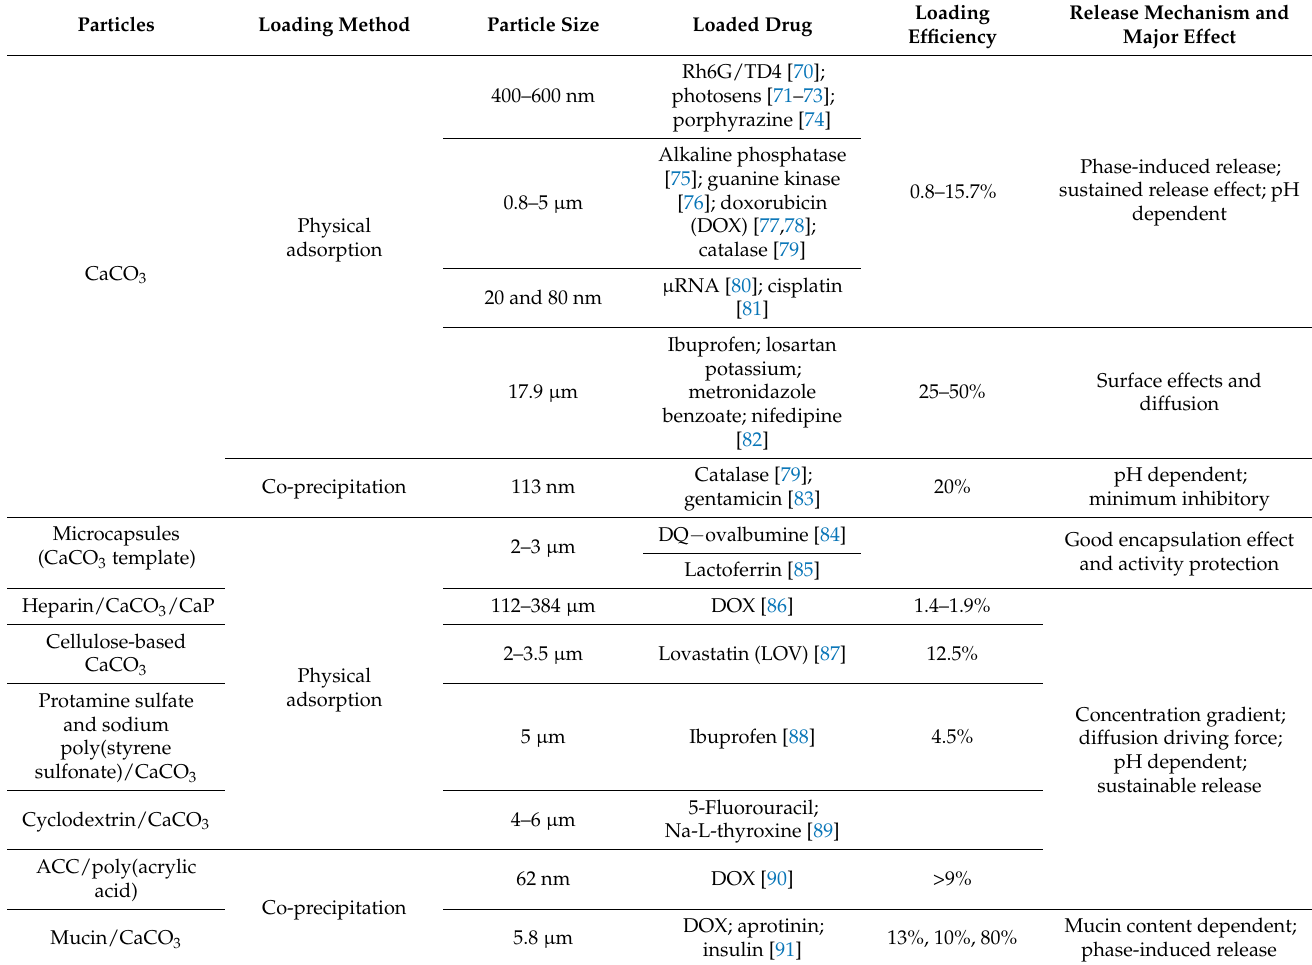
Table 1. Studies on the application of CaCO 3 -based carriers in drug